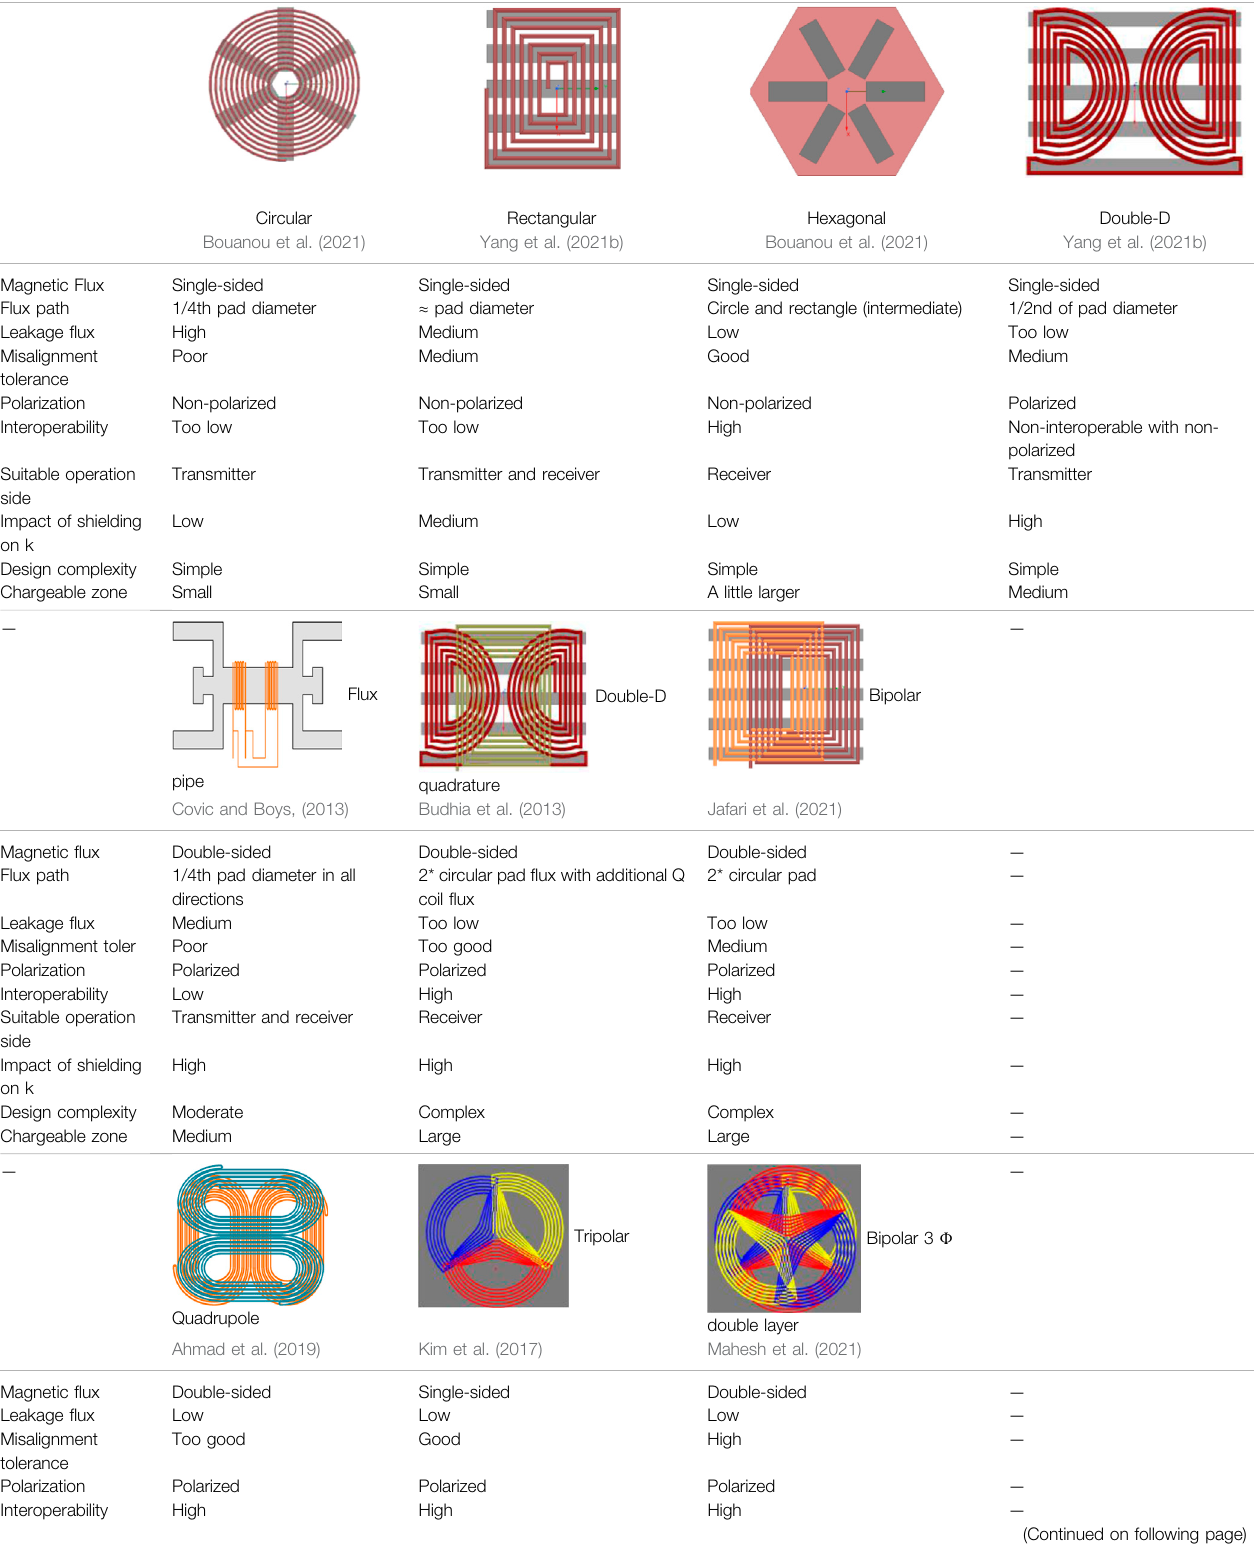
TABLE 2 | Comparison of different coil